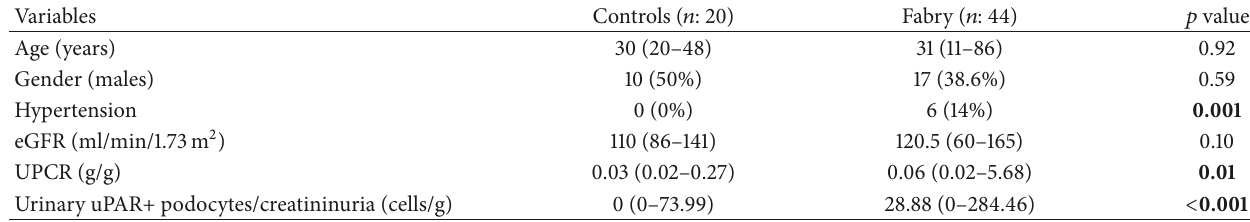
Table 1: General characteristics of controls and Fabry